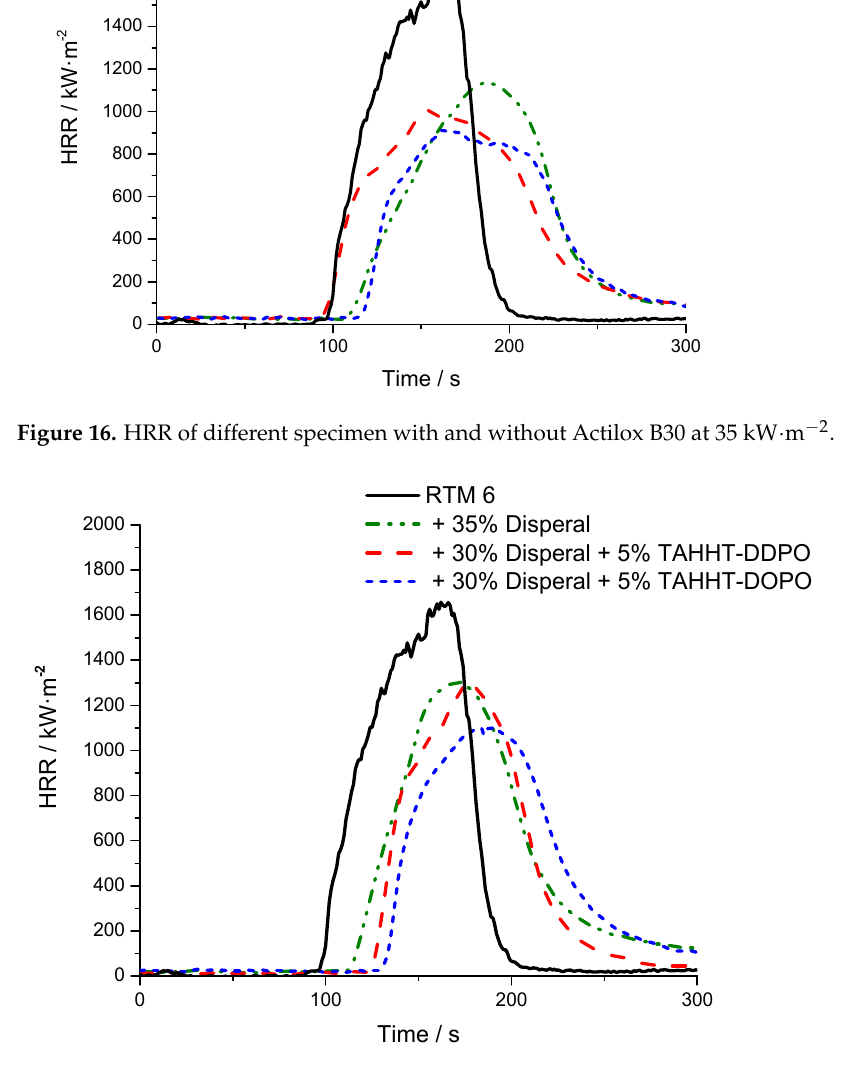
Figure 17. HRR of different specimen with and without Disperal 40 at 35 kW·m − 2 .